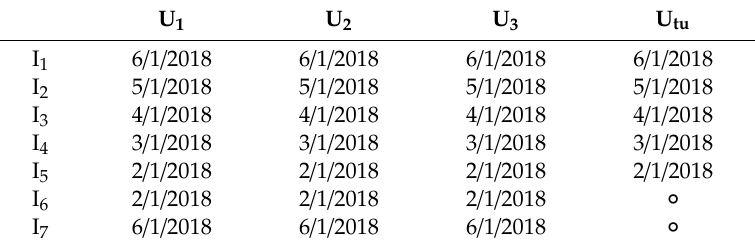
Table 2. Example of user-item time matrix.